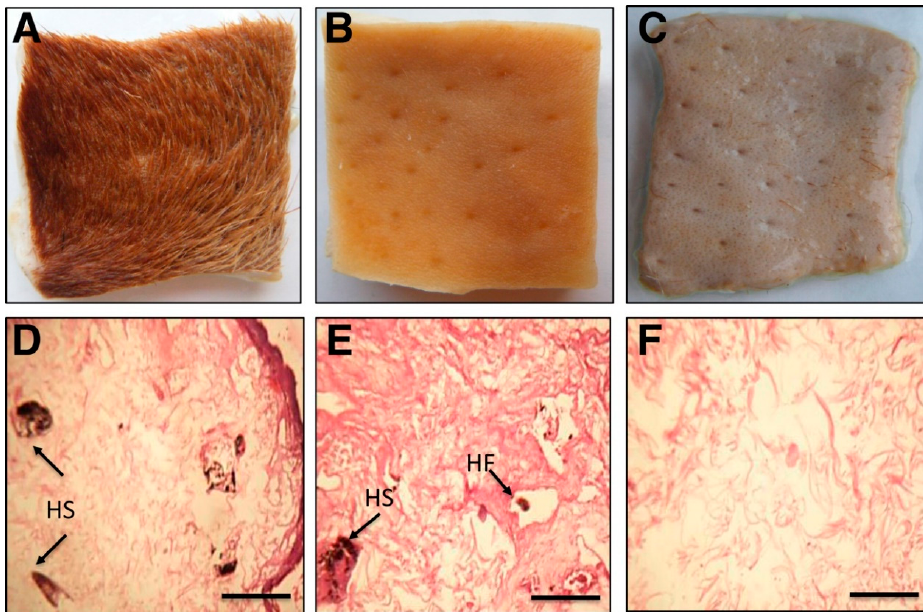
Figure 5. Dehairing efficiency of cow skin mediated by B. megaterium -TK1-derived (partially purified) protease or chemical treatment. ( A ) Cow skin with hair as control. ( B ) Chemical treatment of cow skin. ( C ) Enzymatic treatment of cow skin. ( D ) Cow skin with hair as control. ( E ) Chemical treatment of cow skin. ( F ) Enzymatic treatment of cow skin. ( D – F ) are photomicrographs from ( A – C ) samples at 100× magnification of a longitudinal cross-section of cow skin. Chemical treatment of cow skin still retained hair shafts (HS) and hair follicles (HF). Fotos were taken from collected cow skin pieces (4 cm × 4 cm, ( A – C )); scale bar = 250 μ m ( D – F ). Table 5. Comparison of pollution load generated during cow skin dehairing by chemical processing and treatment with the partially purified protease.